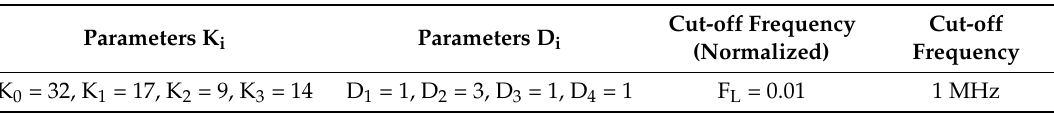
Table 2. Filter parameter employed in